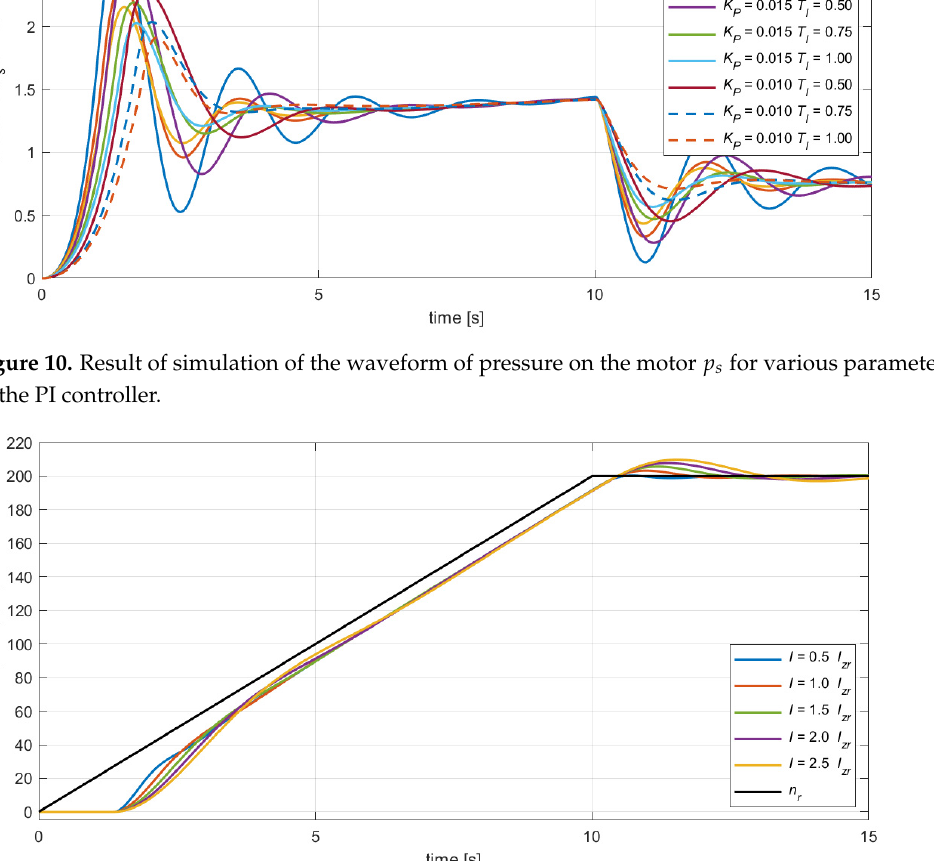
Figure 12. Result of simulation of the waveform of pressure on the motor 𝑝 (cid:3046) for various moments of inertia of the system ( 𝐾 (cid:3017) = 0.015, 𝑇 (cid:3010) = 0.75 s) . 3. Experimental Verification of the Mathematical Model Experimental studies were conducted to verify the mathematical model, the assumed values of the parameters, and the assumptions. The experimental studies also made it possible to determine the relation between the shape (parameters) of the control signal for the proportional spool valve and the dynamic surplus pressure (at the inlet port of the motor) and the speed on the shaft of the motor. Additionally, the duration of the start-up process was analysed for various waveforms of the control signal for the proportional spool valve. Figure 13 shows the test stand that was used to verify the model. The hydraulic power source is based on an axial variable displacement piston pump (flow was set to 14 L/min ). The system is protected by a direct operating relief valve (nominal flow 25 L/min ). A direct proportional spool valve (nominal flow 16 L/min ) with spool position feedback was used to control the gear motor (size 32 cm 3 /rev ). The control signal was generated using a multifunction DAQ device with analogue I/O (NI USB-6001) connected to a PC with dedicated LabVIEW-based software. The measurement system was based on